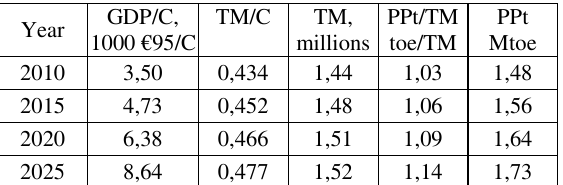
Summary of average forecasts of basic scenario